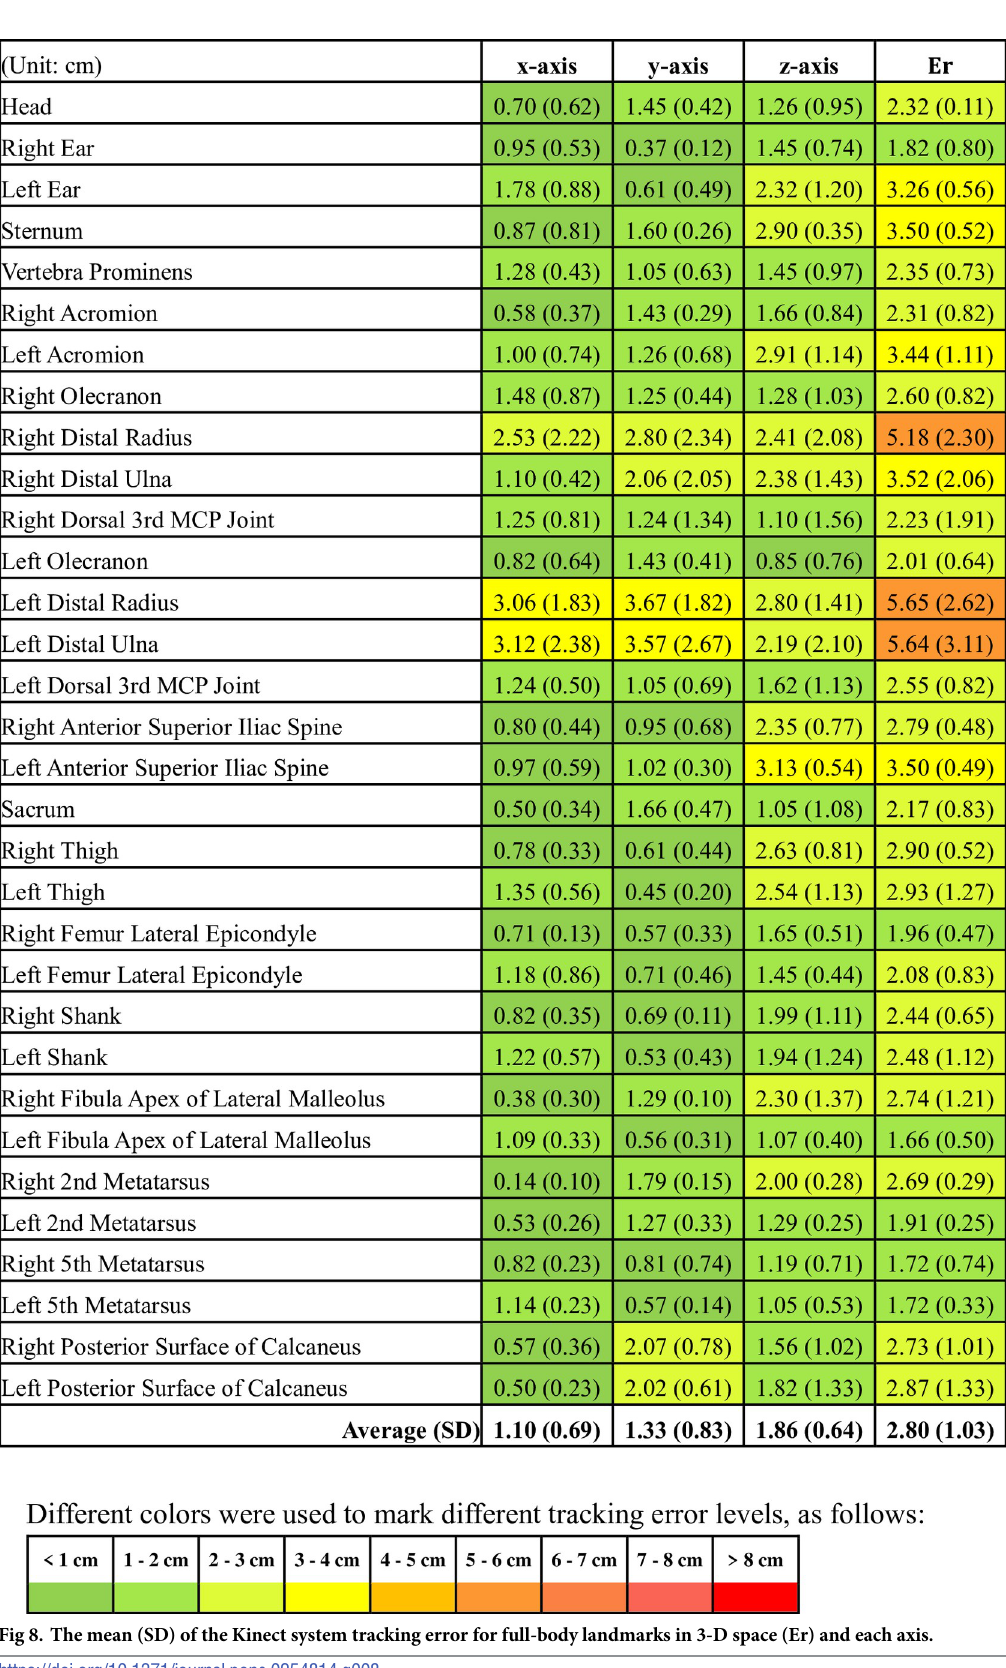
Fig 8. The mean (SD) of the Kinect system tracking error for full-body landmarks in 3-D space (Er) and each axis. https://doi.org/10.1371/journal.pone.0254814.g008 PLOS ONE | https://doi.org/10.1371/journal.pone.0254814 July 21,